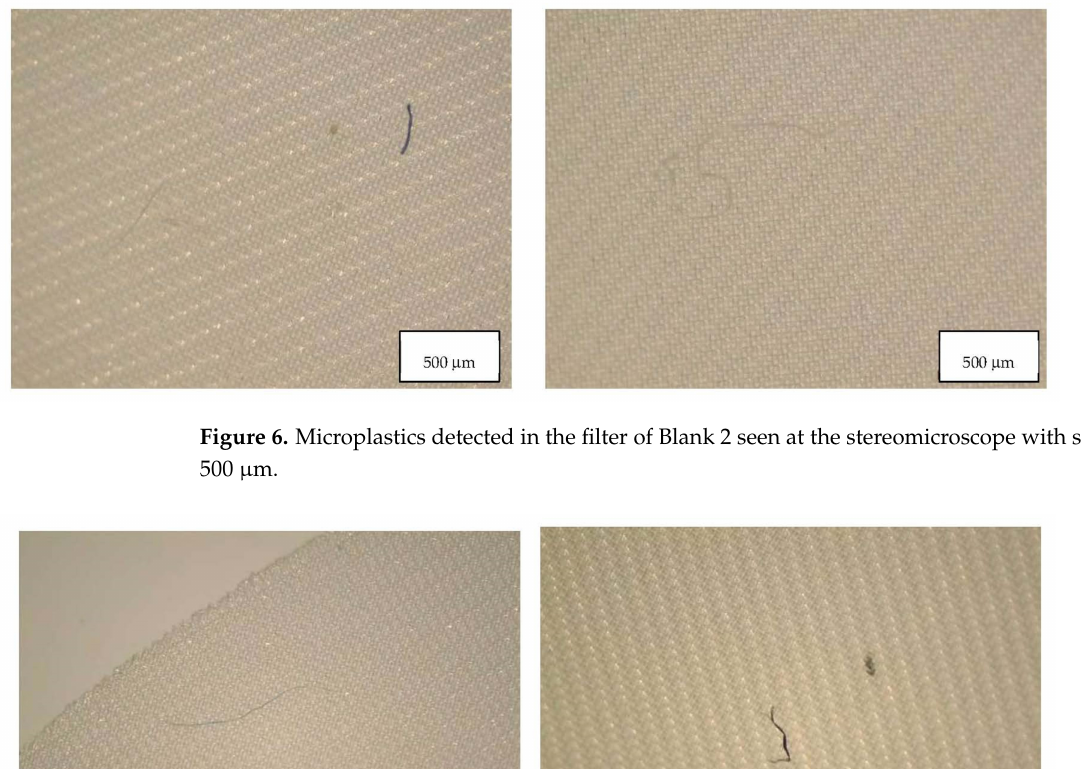
Figure 5. Microplastics detected in the filter of Blank 1 seen at the stereomicroscope with scale bar of 500 µ m.